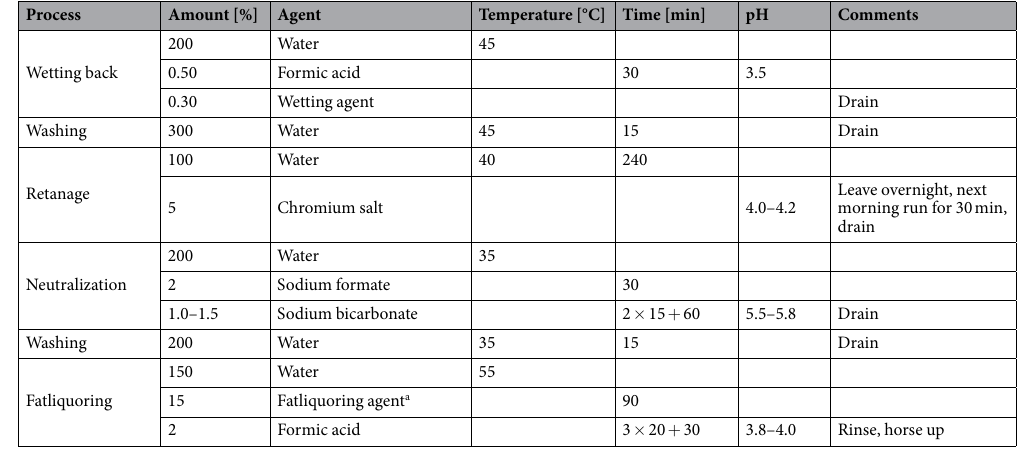
Table 2. Wet-blue fatliquoring process. a Experiment I-15% MHCO/GPTMS-ZnO, Experiment II-15% MHCO, Experiment III-15% commercial